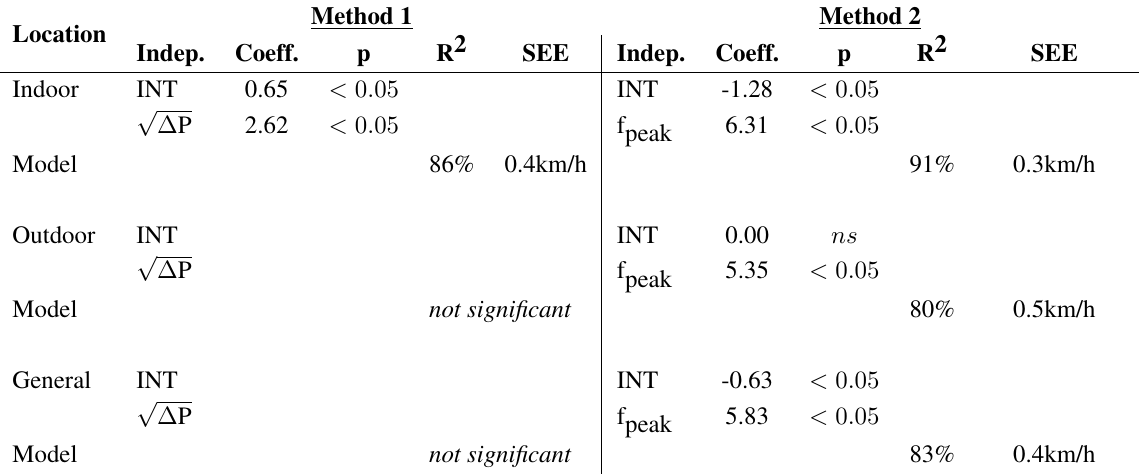
Table 3. Walking speed prediction models based on near-body air flow